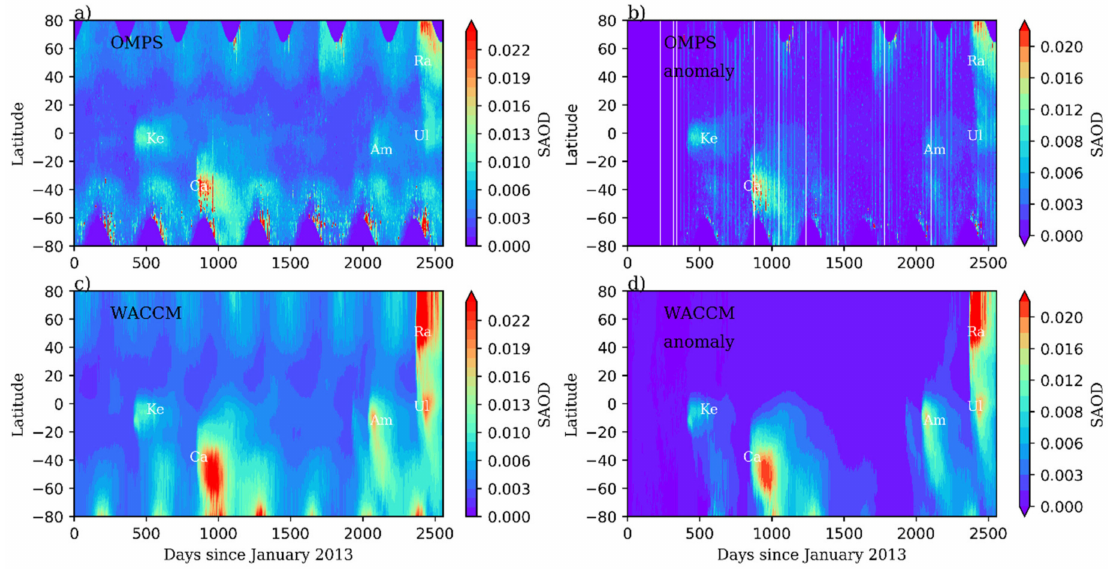
Figure 3. Comparisons of daily- and zonally averaged time evolution of SAOD (left panels) at different latitudes as measured by OMPS ( a ) and simulated by WACCM-CARMA ( c ). Also presented are the anomalies (right panels) for OMPS ( b ) and WACCM-CARMA ( d ). SAOD and anomalies have been calculated from 1 km above the tropopause to 30 km. Model outputs are taken from the volcano-on simulation. Volcanic plumes of Kelud, Calbuco, Ambae and Ulawun/Raikoke are denoted by Ke, Ca, Am, Ul/Ra respectively. The signature of the Canadian wildfire smoke is visible north of 40 ◦ N in summer 2017 in OMPS data but is not computed in the WACCM-CARMA model. Seasonal zero values of SAOD observed by OMPS at high latitudes are due insufficient solar illumination to get